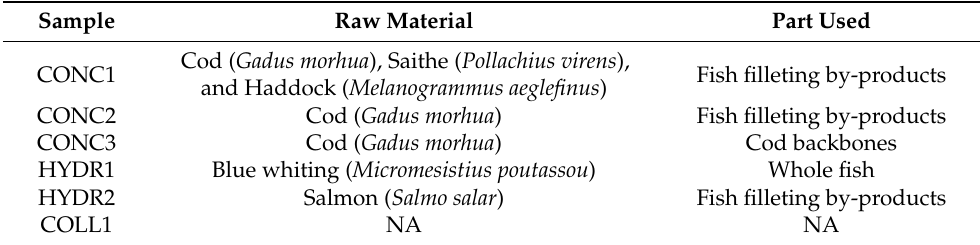
Fish filleting by-products Whole fish